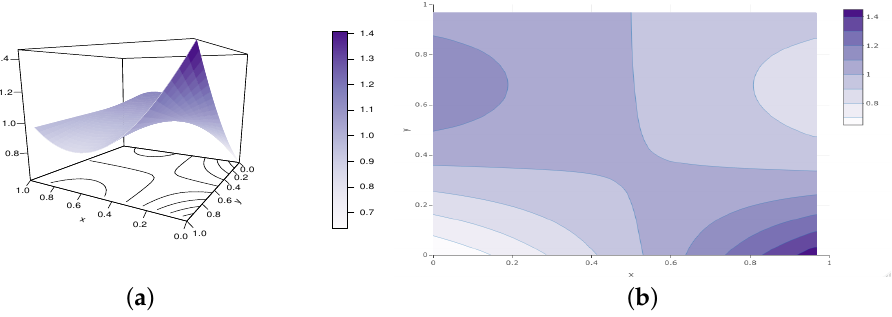
Figure 10. Illustrations of the ( a ) perspective plot and ( b ) contour plot of the SGCC copula density for the following configuration: a = − 1/2, b = 2, and c = 1, belonging to Configuration